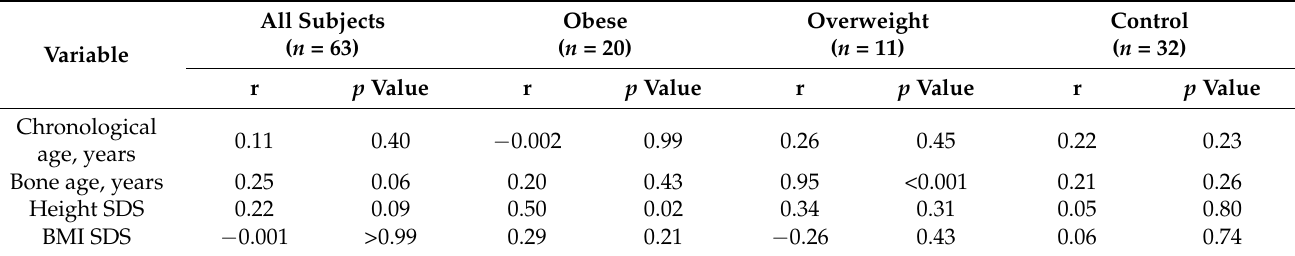
Table 2. Correlation between serum sclerostin and anthropometric